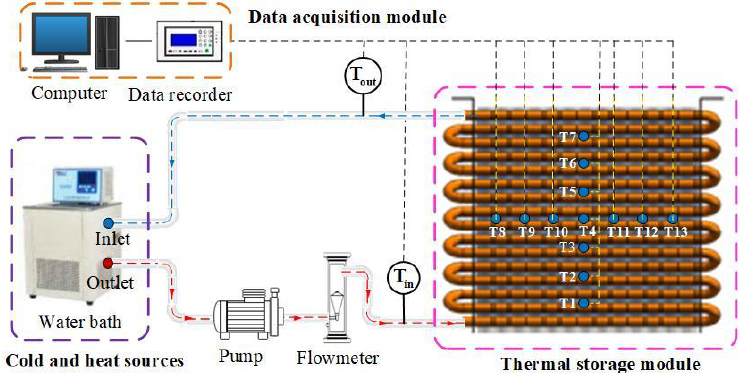
Figure 5. Schematic diagram of the experimental apparatus.